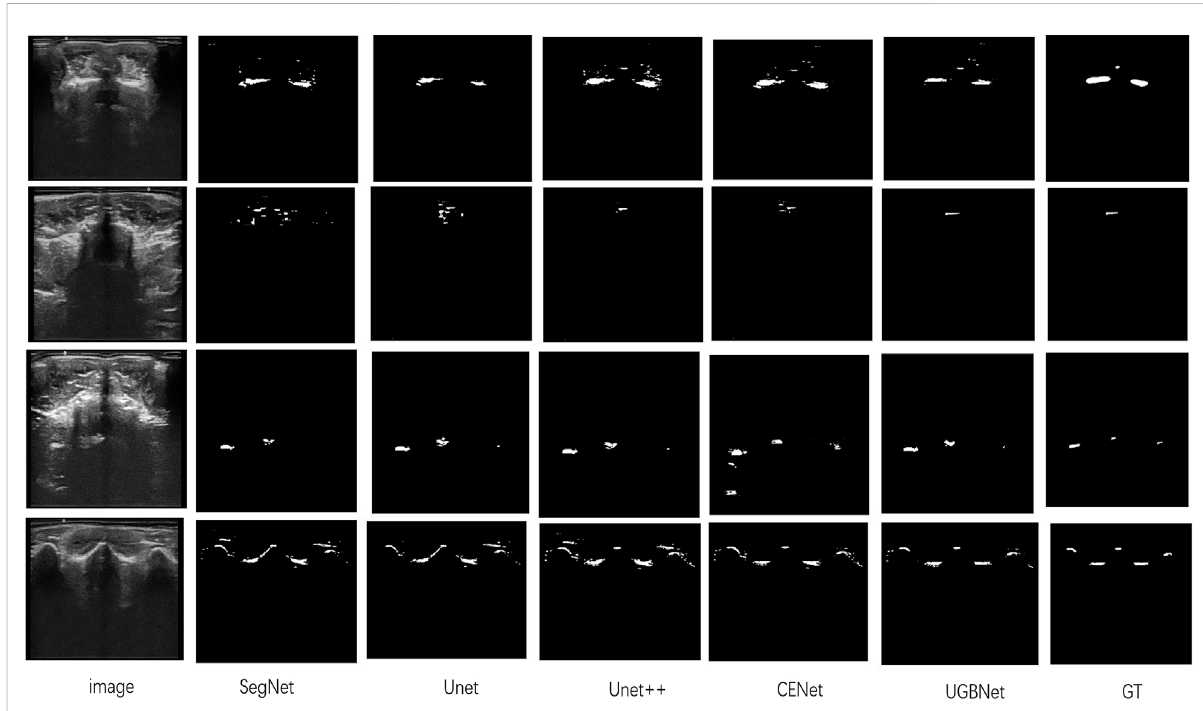
FIGURE 6 Segmentationresults of differentmethods onour spinal ultrasoundimagedataset. The ground truthisdenotedas GT. From leftto rightare our original images and the segmentation results of SegNet, Unet, Unet++, CENet, and our method. The last column is the ground truth.